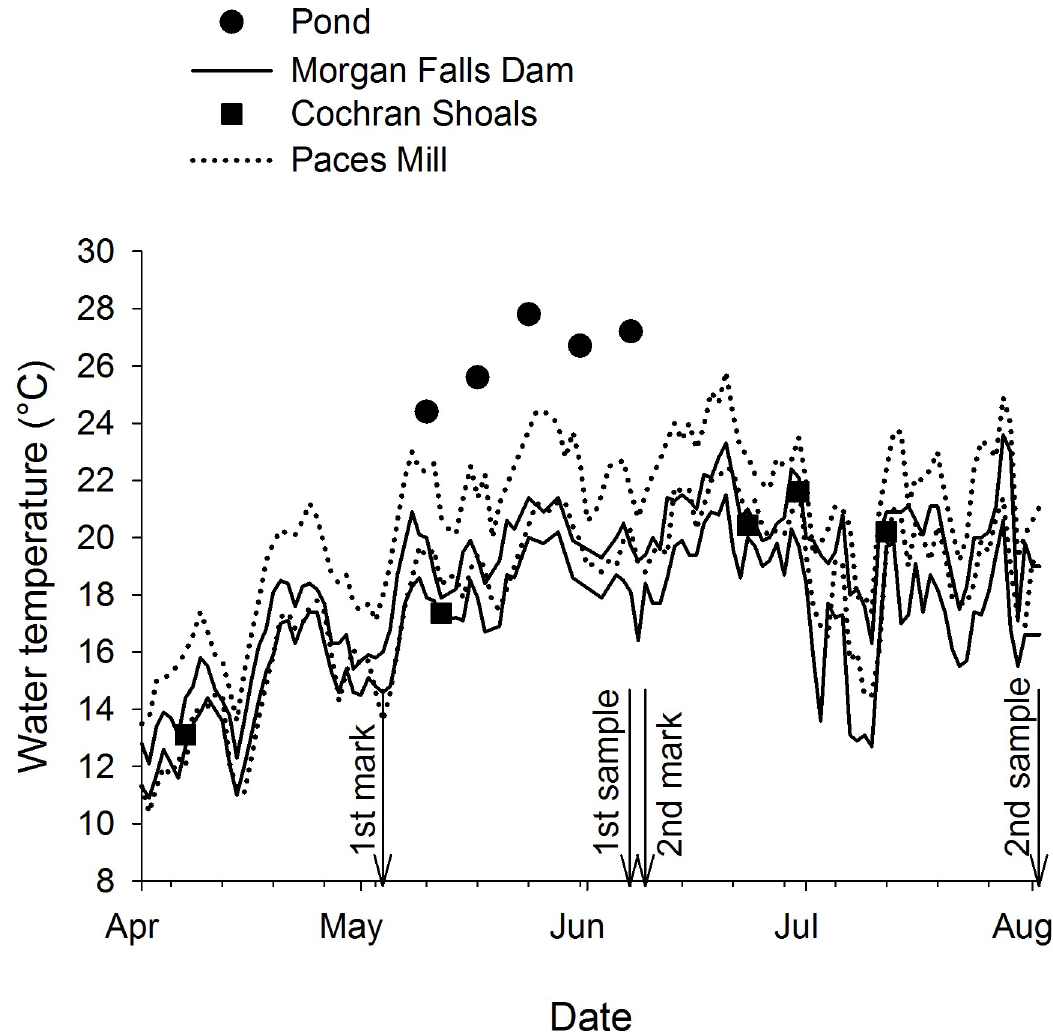
Fig 4. Temperature in the Chattahoochee River and the hatchery pond where Shoal Bass were sampled. The paired lines represent the maximum and minimum daily temperatures for Morgan Falls Dam and Paces Mill in the Chattahoochee River. Squares indicate point temperature values for the Chattahoochee River in the vicinity of Cochran Shoals. Circles indicate the hatchery pond water temperature that was taken haphazardly during the time Shoal Bass were present. The dates on which Shoal Bass were marked and sampled are indicated with arrows. See Fig 1 for locations in the